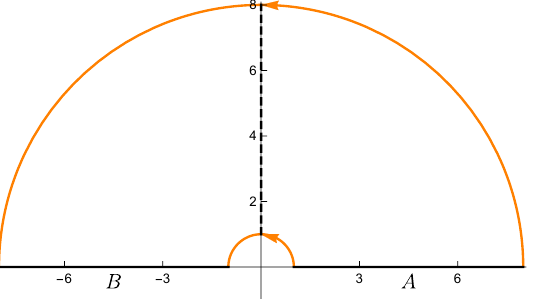
Figure 10 . A covering space (upper half space H 2 ) depiction of (cid:12)gure 1a, the time-re(cid:13)ection- symmetric slice of the eternal two-sided black hole. The orange geodesics are identi(cid:12)ed, and the black segments are asymptotic boundaries A and B . The vertical dashed black line is the bifurcate horizon, the modulus of the real geometry. The region between the orange and black arcs is a fundamental region for (cid:6) 2